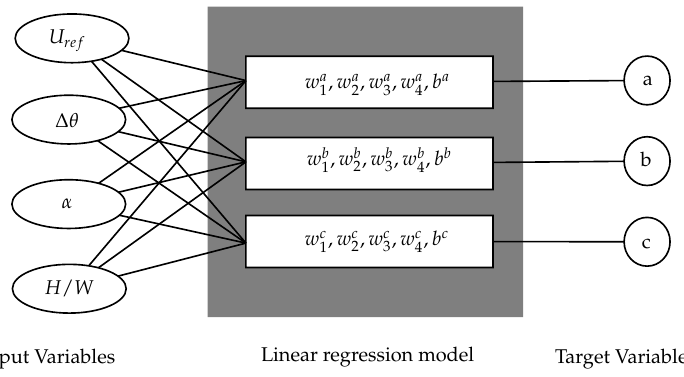
Figure 11. Linear regression model